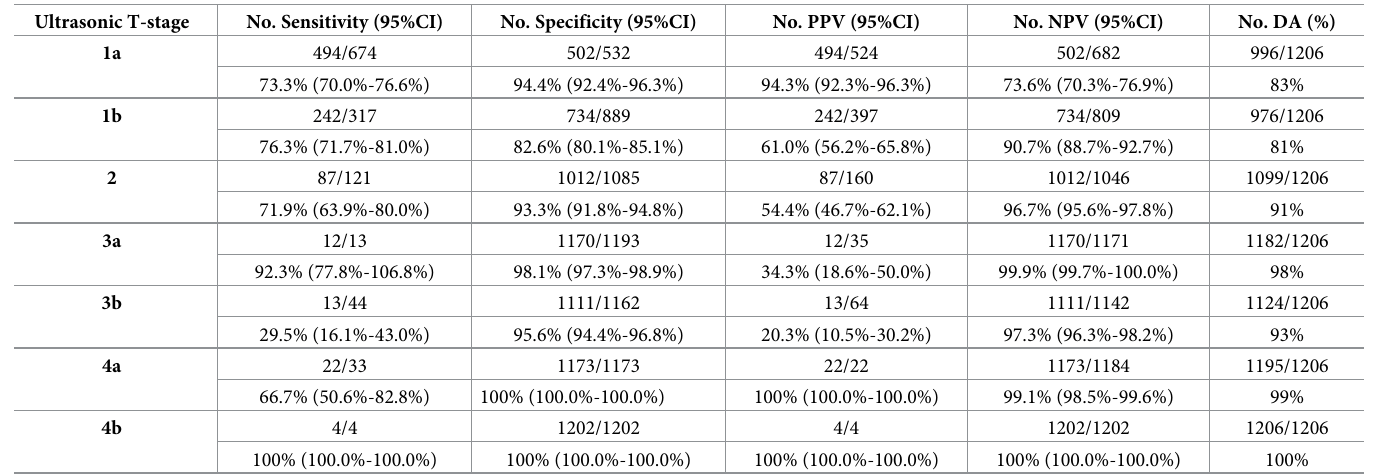
According to the calculation presented above, the ultrasonic N-stage had poor consistency with the pathological N stage in all N stages (kappa value < 0.3 in all N stages) (Table 6). According to the calculations in Table 7, ultrasonic N-stage had sensitivity lower than 50% except in N1, N1a and N1b assessment (Table 7). Although its sensitivity was 87.7% (95%CI: